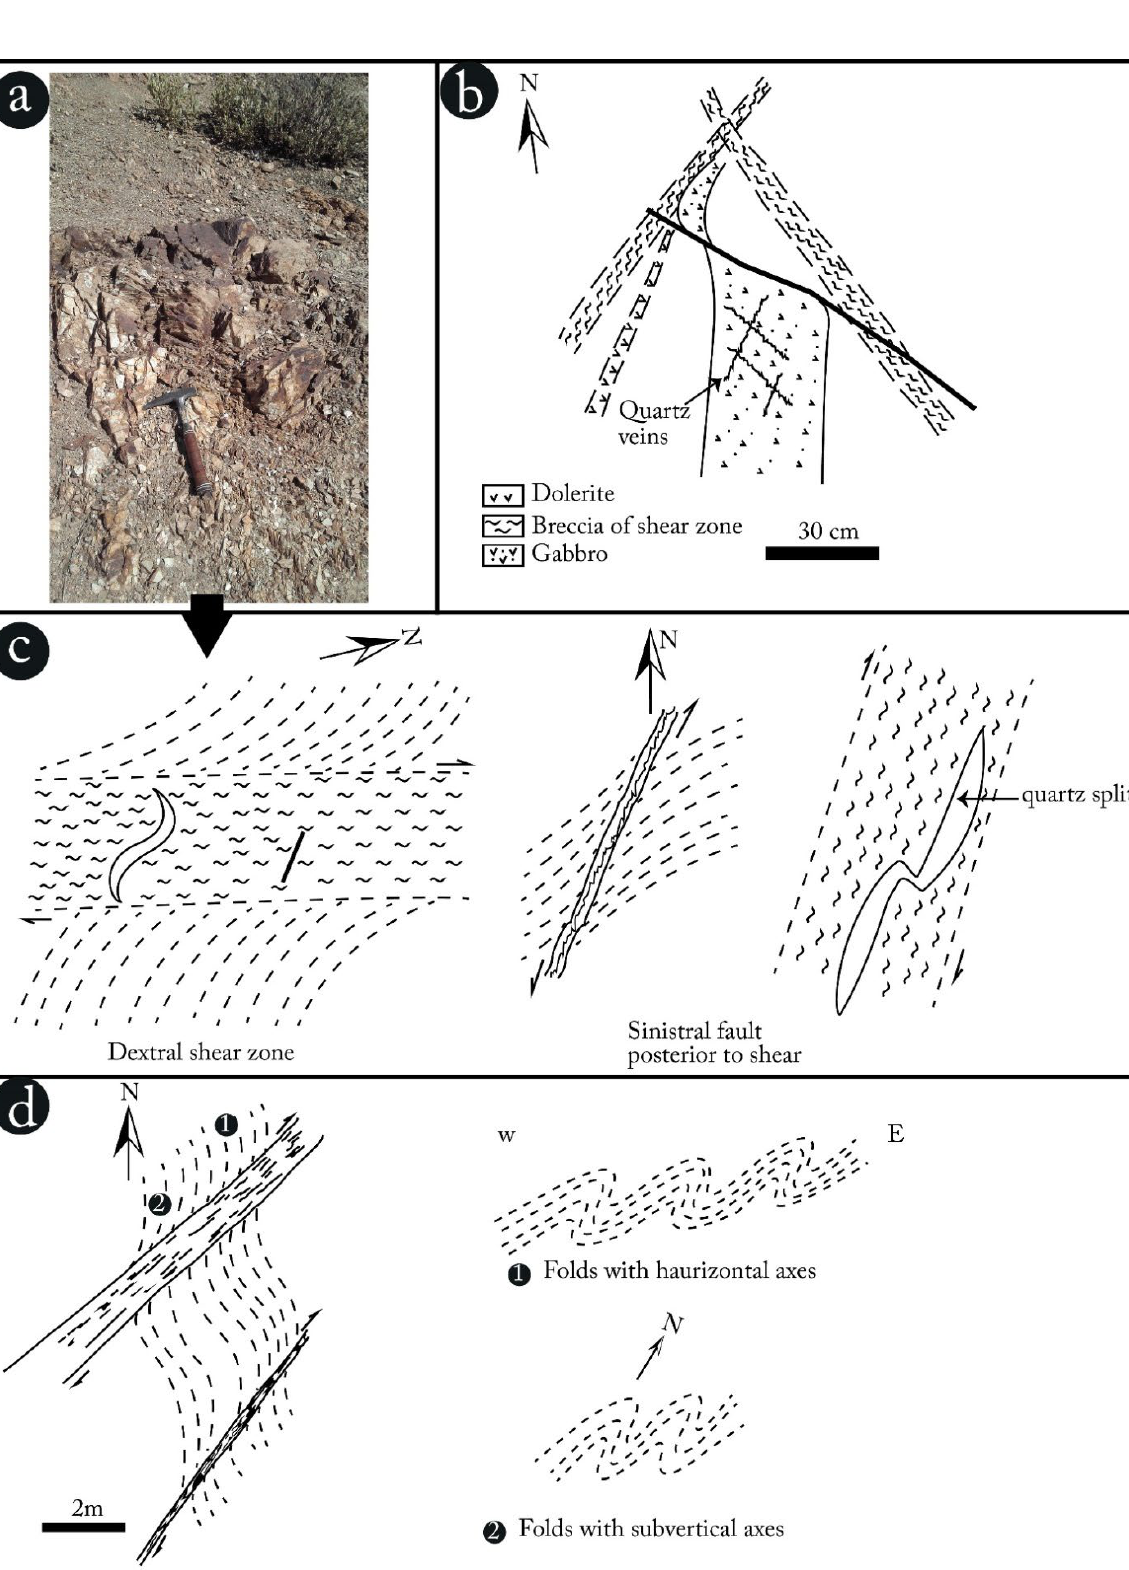
Figure 10. ( a ) Breccia in shear zone A (north of the studied zone), ( b ) N130° E sinistral fault in dolerite dike, ( c ) shear zone deformation in zone B and ( d ) shear zone deformation in Zone A.